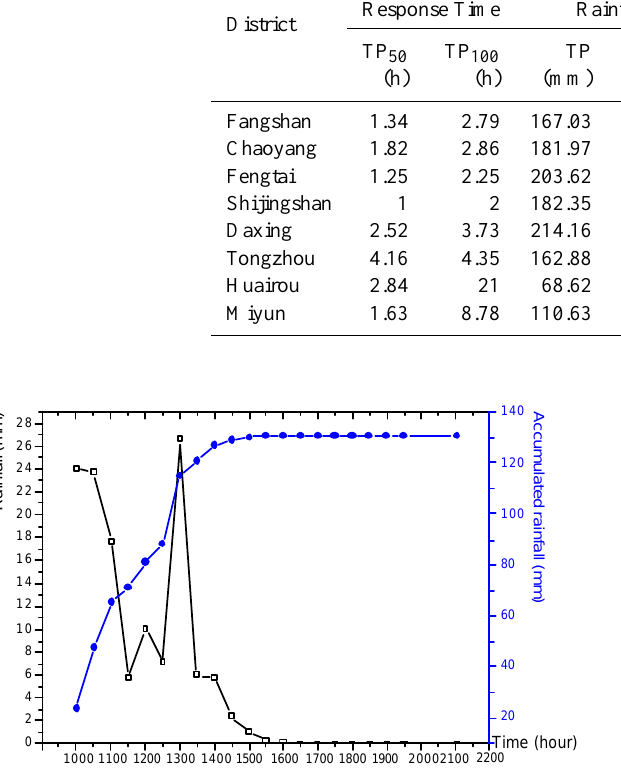
Fig. 6. Hourly and accumulated rainfall of Beijing between 09:00UTC and 21:00UTC on 21 st -22